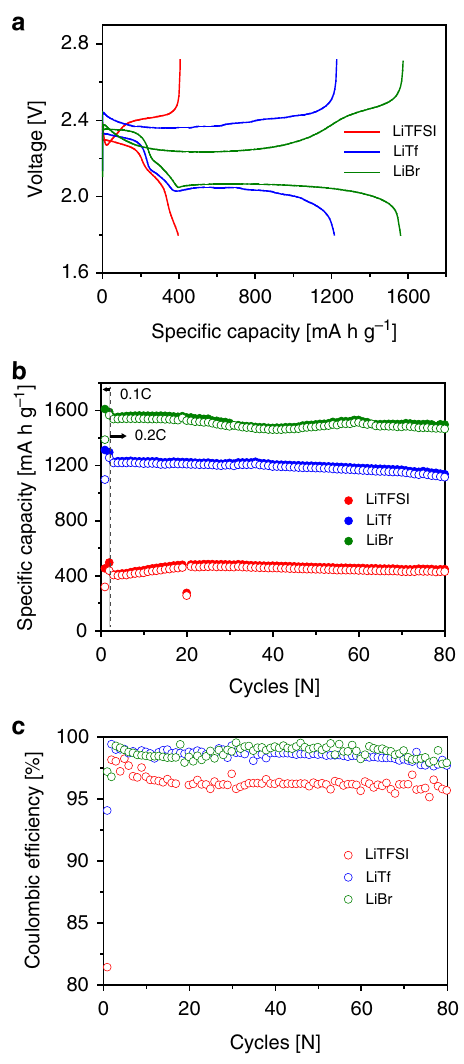
Fig. 1 Electrochemical performances of the lithium – sulfur cells with varying anions. a Charge and discharge curves of the fi rst 0.2 C cycle, b comparison of the charge (closed circle) and discharge (open circle) capacities, and c Coulombic ef fi ciency data for 80 charge/discharge cycles at 0.2 C. The electrolytes consist of 0.2 M lithium polysul fi de (LiPS, Li 2 S 8 based) with 1